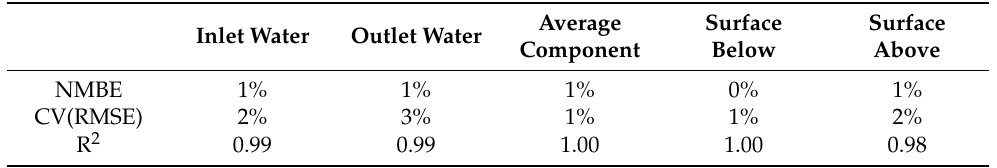
Table 2. Statistical indices of comparing the simulation to the temperature measurement of a single example case on the ceiling TABS storage for new